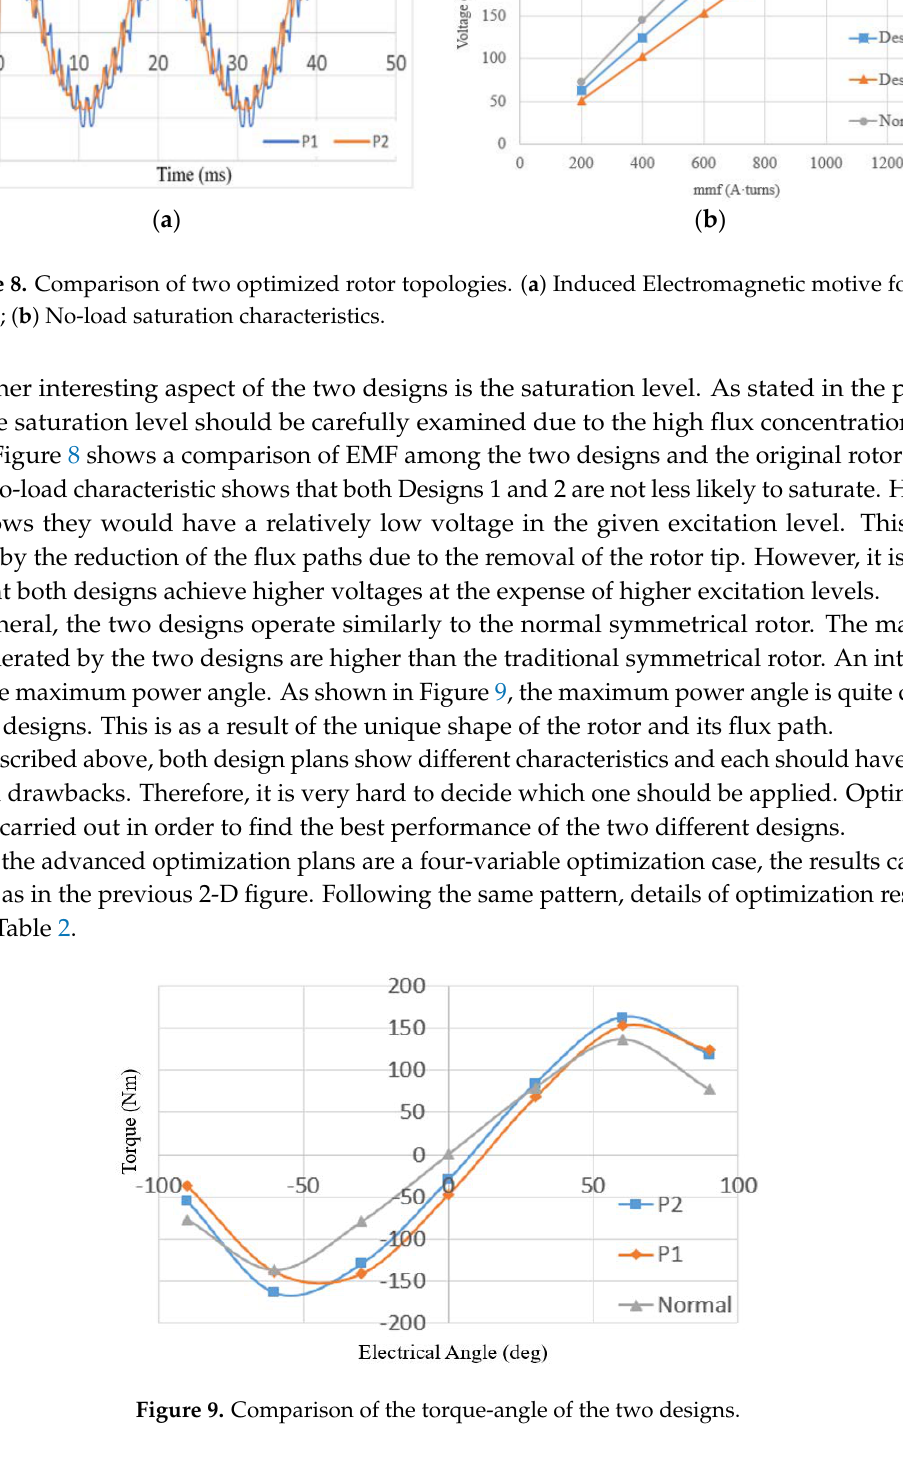
Table 2. Optimized results of the two rotors.